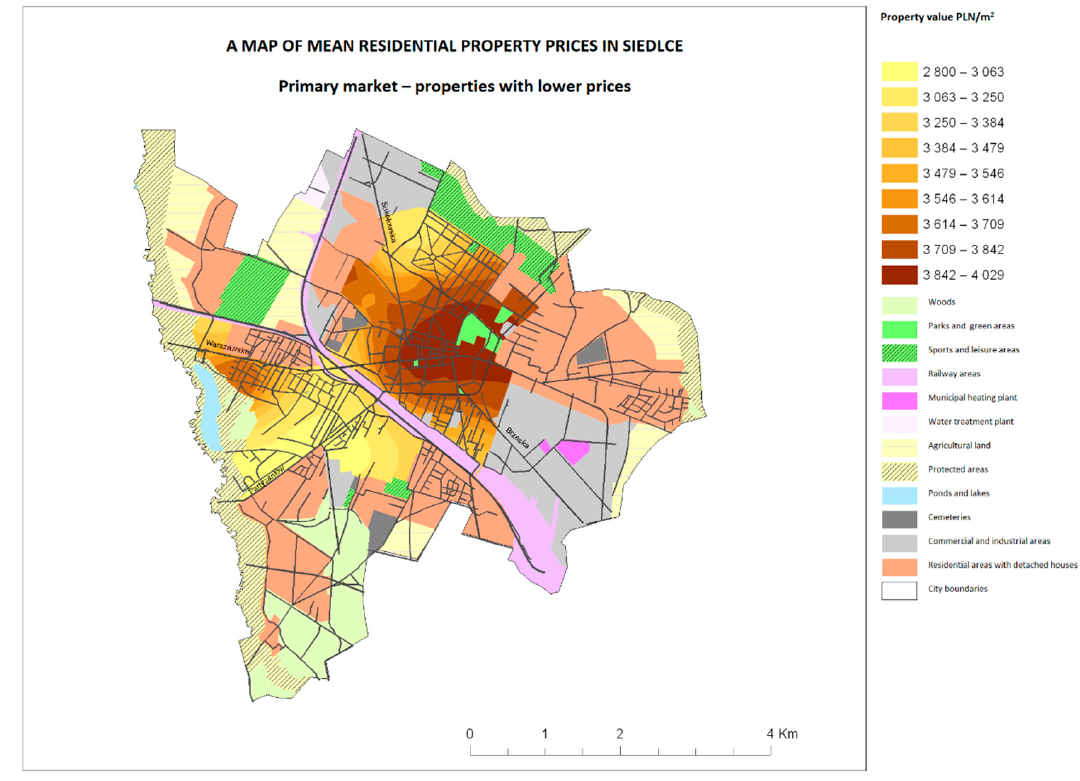
Figure 4. Map of residential property values.